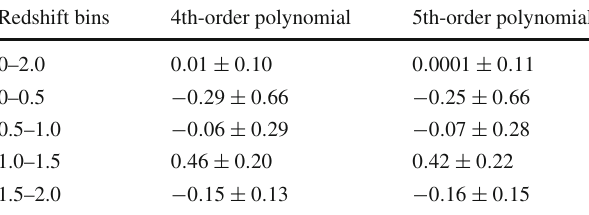
Table 2 Weighted average of Ω k in different redshift bins from CC+DECIGO based on fourth and fifth order logarithmic polynomial Redshift bins 4th-order polynomial 5th-order polynomial